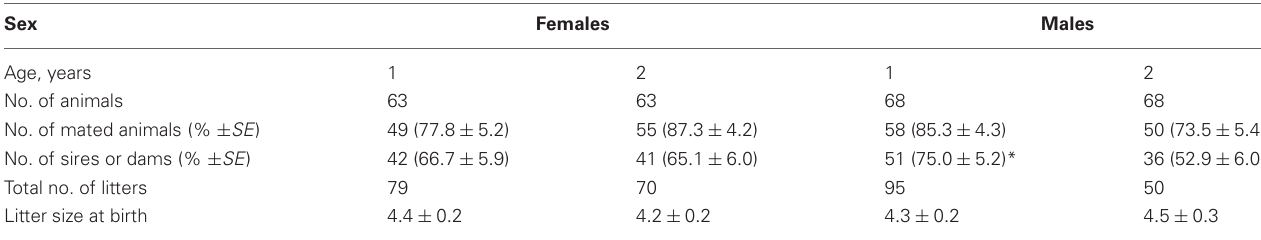
Table 2 | Reproductive characteristics of females and males aged one and two